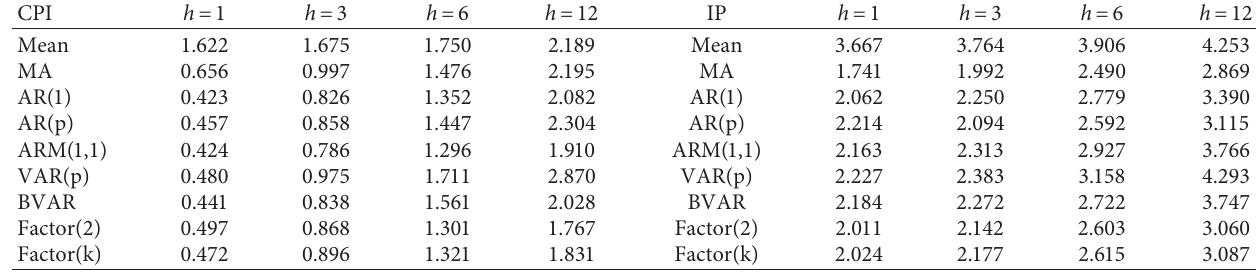
Table 2: MAE values predicted by CPI and industrial added value in China.